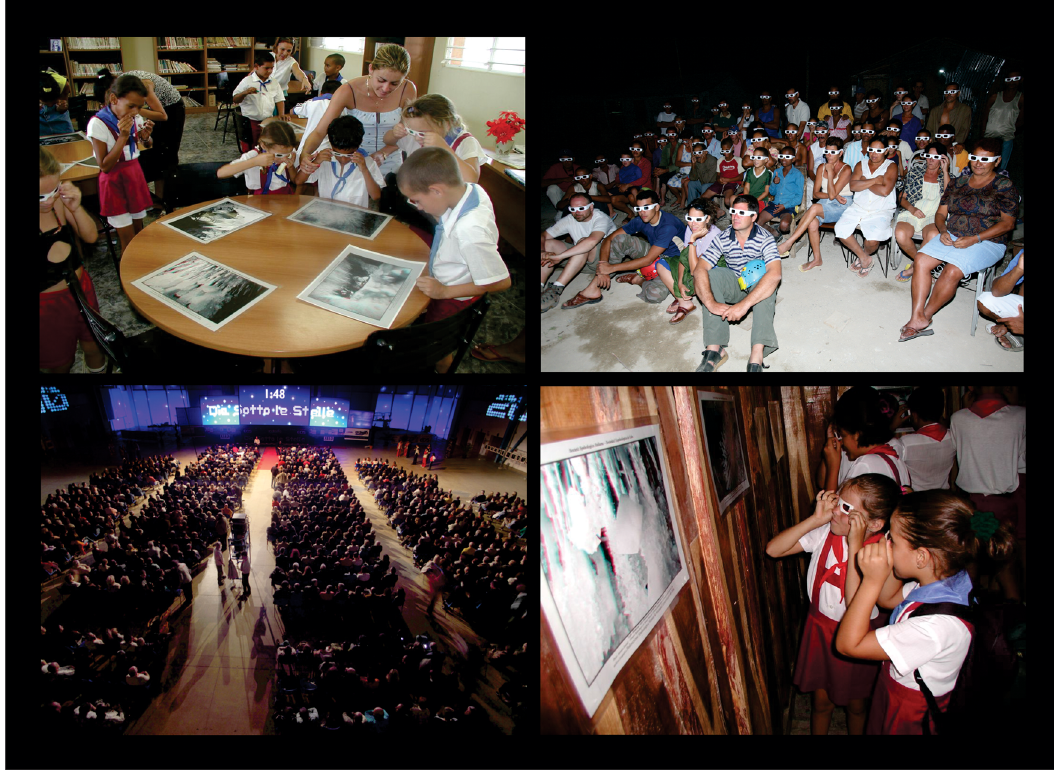
Figure 11: Previous 2D and 3D exhibitions of Cuban natural and historical heritage by the La Salle